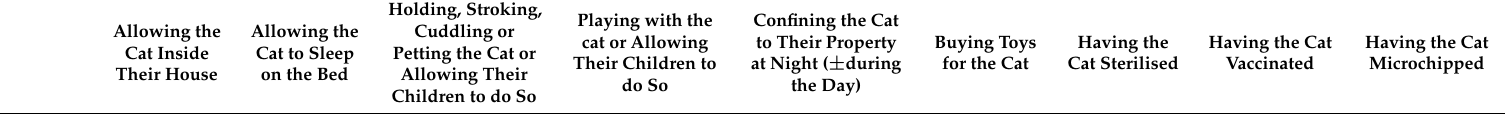
Table 3. Phi coefficients for associations between surrenderers’ cat caretaking behaviours and interactions 1